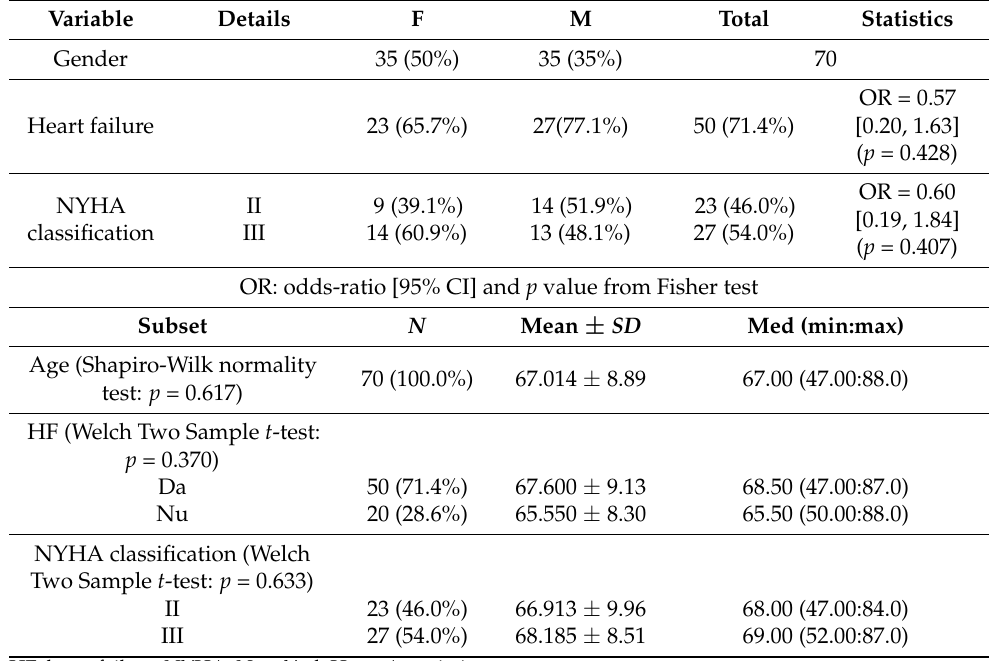
Table 5. The presence of negative prognostic factors (age, sex, and heart failure) in patients with LBBB. Variable